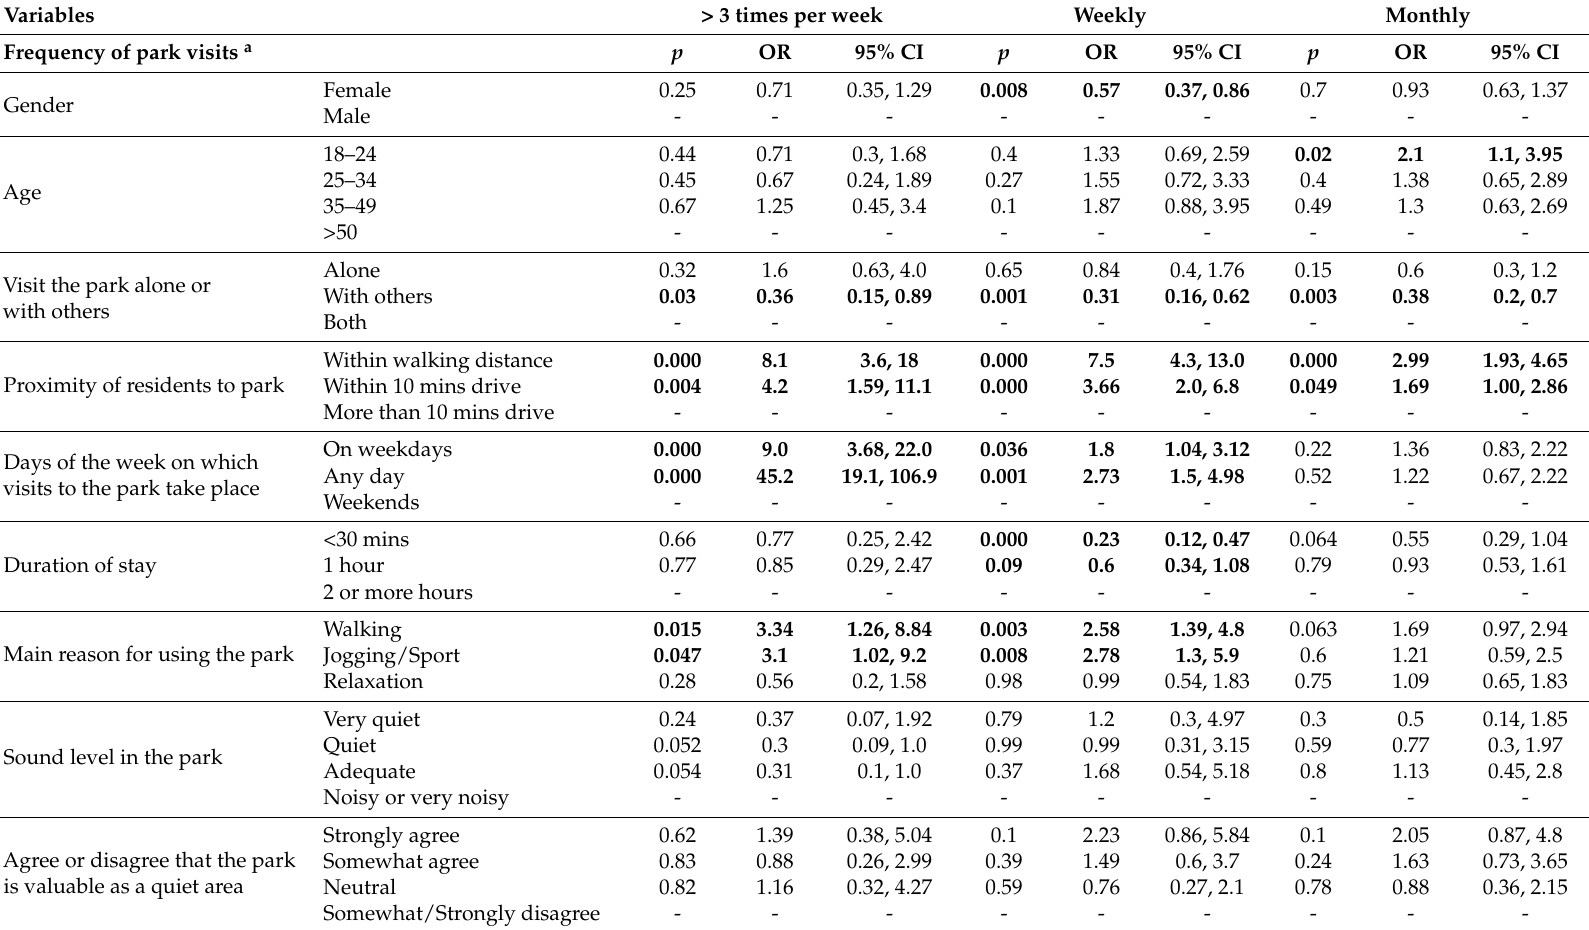
Table 3. Multinomial logistic regression parameter